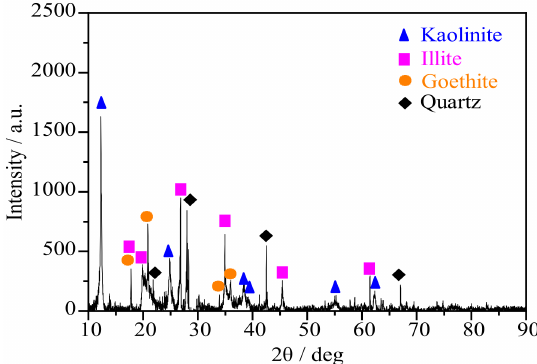
Figure 1. X-ray diffractometry spectrum of the IREO colloids.